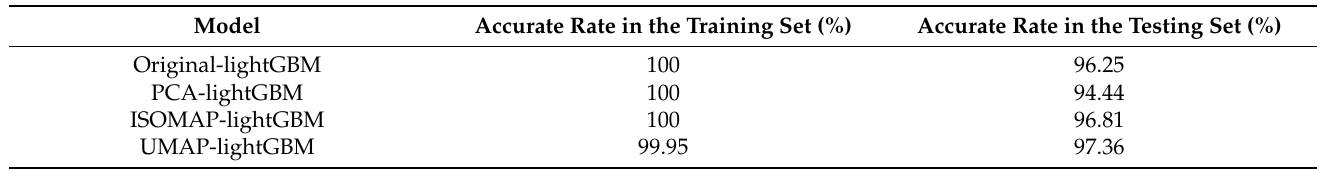
Table 3. The classification results in the training set and testing set based on